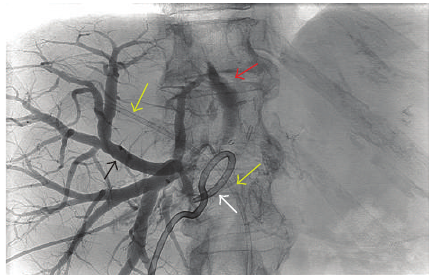
Figure4:Confirmationofanomalousbiliaryanatomy.Transhepatic cholangiogram. Yellow arrows show endoscopic placed stent in right anterior sectoral duct. There is no contrast in the anterior sectoral duct or its branches. Black arrows show contrast in the posterior sectoral duct and filling of posterior duct and branches. White arrow shows extrahepatic pigtail placed catheter. Red arrow shows extravasation of bile. This cholangiogram demonstrates that the anterior and posterior ducts are not in